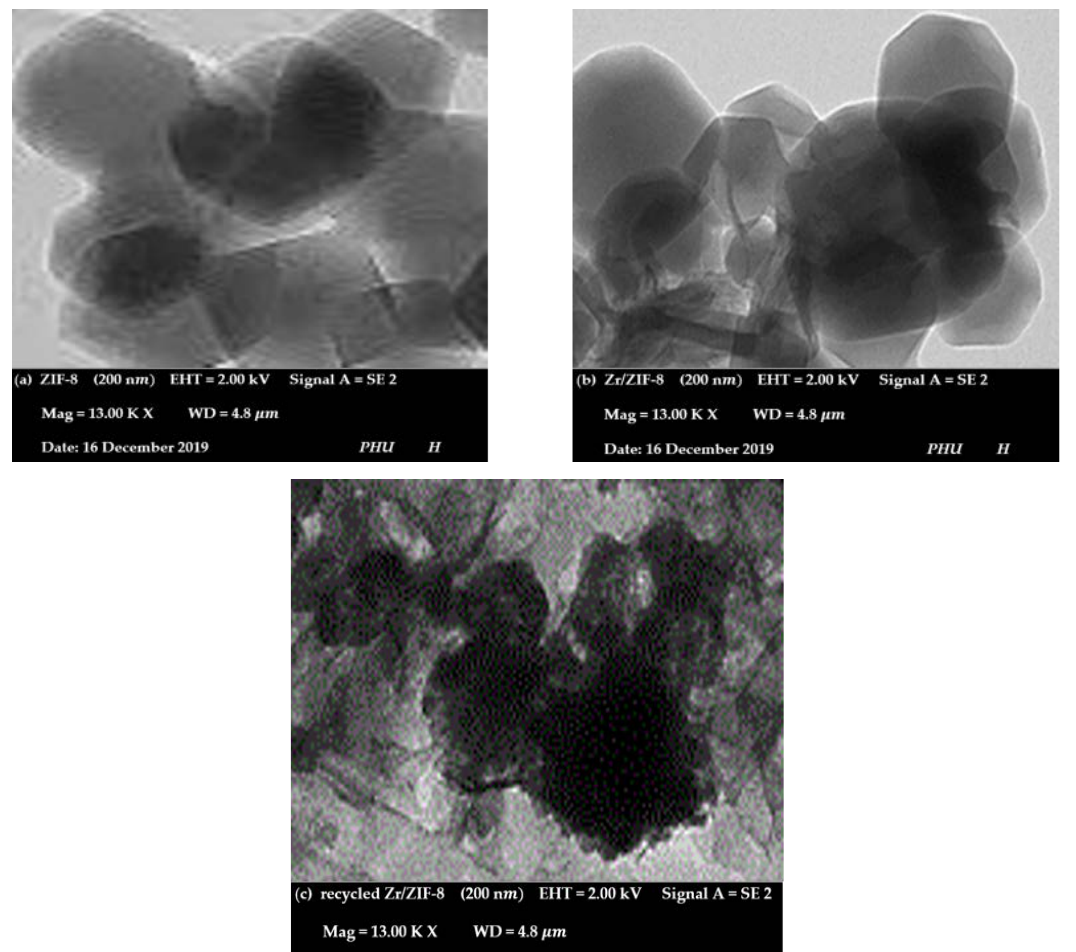
Figure 7. Transmission electron microscopy (TEM) image of ( a ) pristine ZIF-8 crystals, ( b ) Zr / ZIF-8, and ( c ) recycled Zr / ZIF-8 synthesized with 10% dopant of Zr.